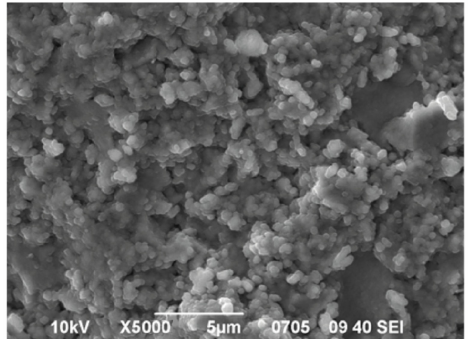
Figure 3. A typical SEM image of a fracture in a nanopowder compact with the composition ZrO 2 — 3% mol Y 2 O 3 (The nanopowder was obtained at an annealing temperature of 400 ◦ C).